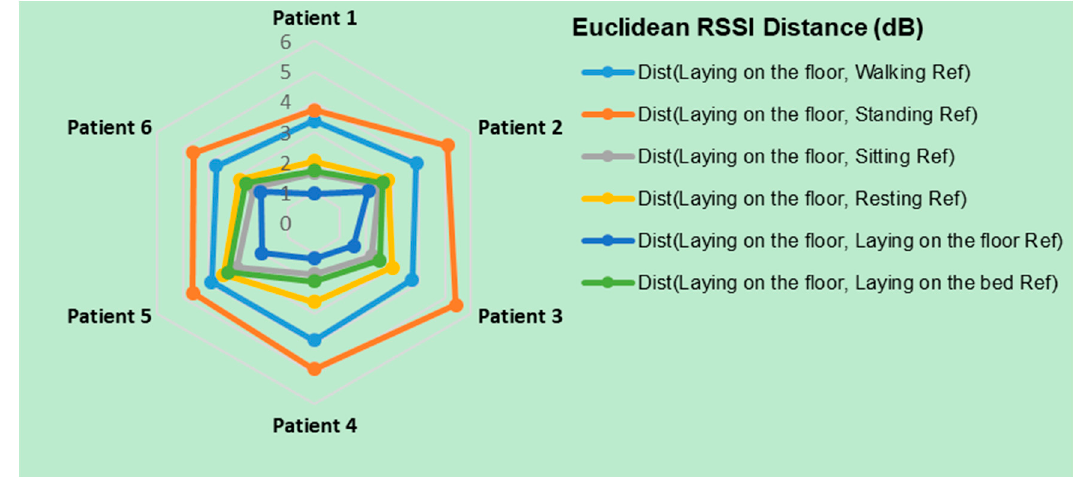
8 of 12 Figure 6. System performance for sitting position over a stipulated timeframe.